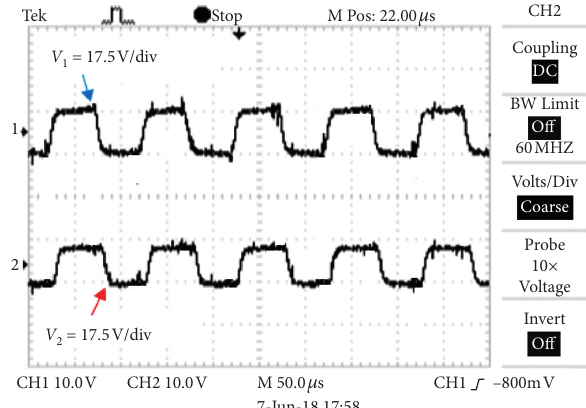
Figure 12: Input V 1 and output V 2 voltages of the ICPT system at 10cm air gap.